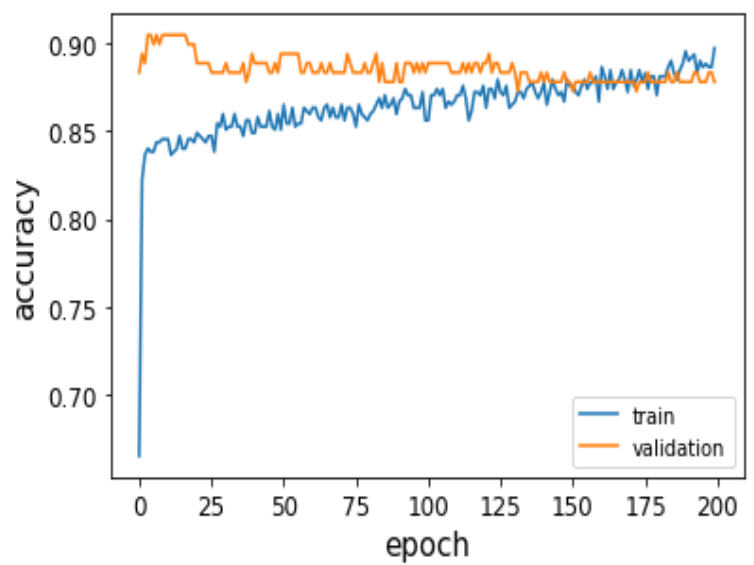
Figure 4. Accuracy plot of training and validation of Deep Learning Neural network model.